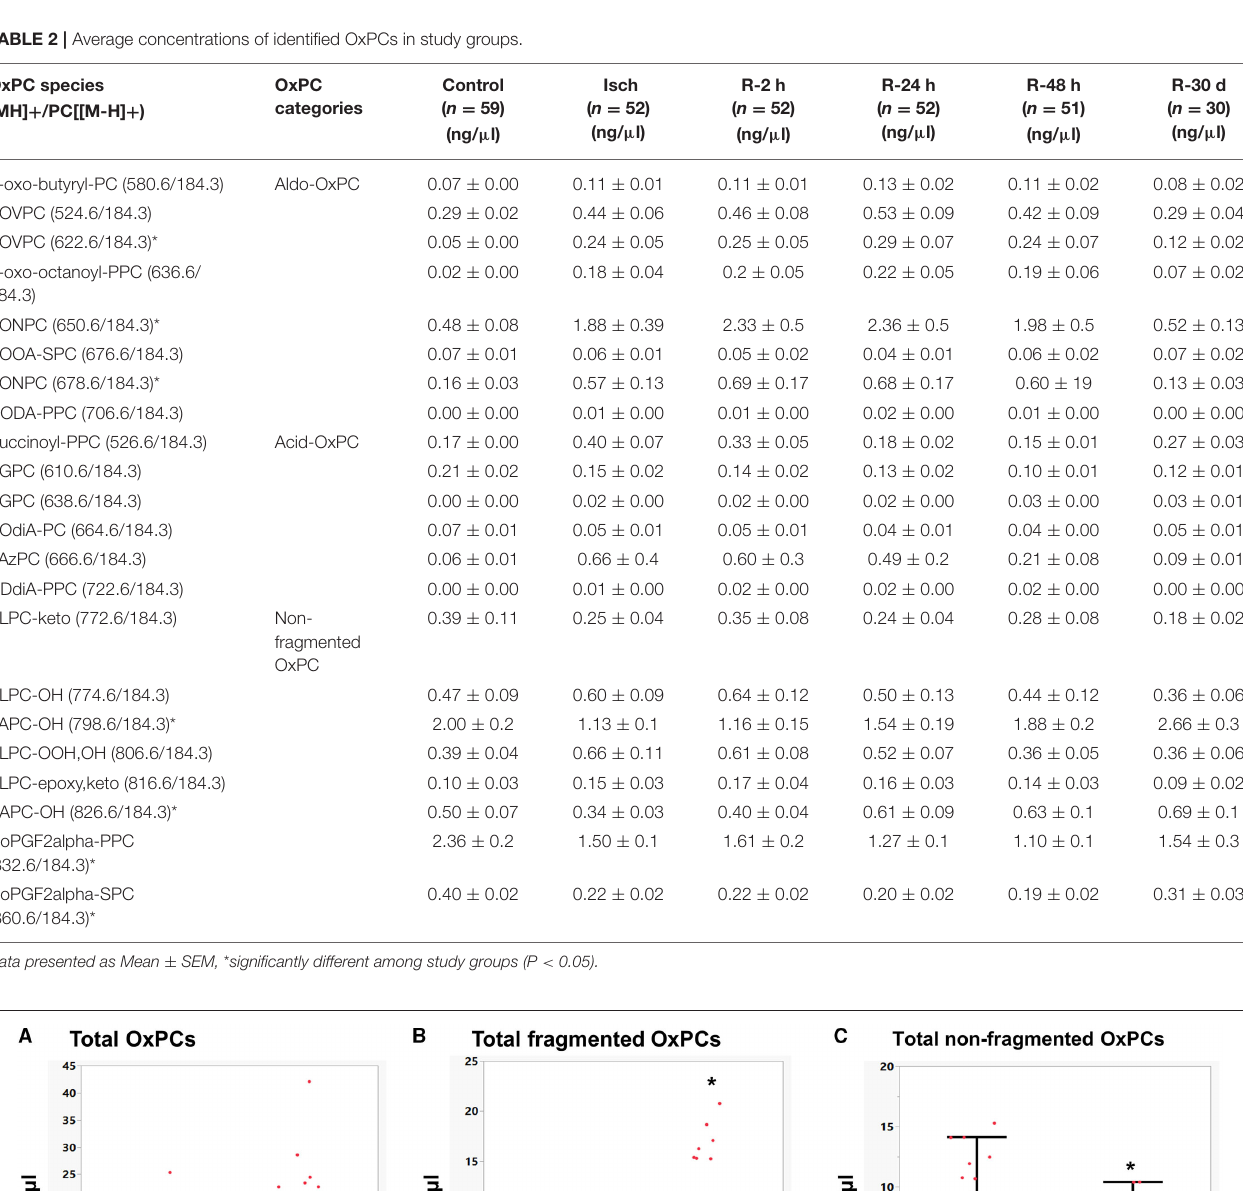
I/R (Isch: 9.63 ± 1.08, R-2 h: 10.48 ± 1.37, R-24 h: 10.24 ± 1.27, R-48 h: 9.20 ± 1.29, and R-30 d: 8.07 ± 1.09 ng/ µ l) ( Table 3 ;